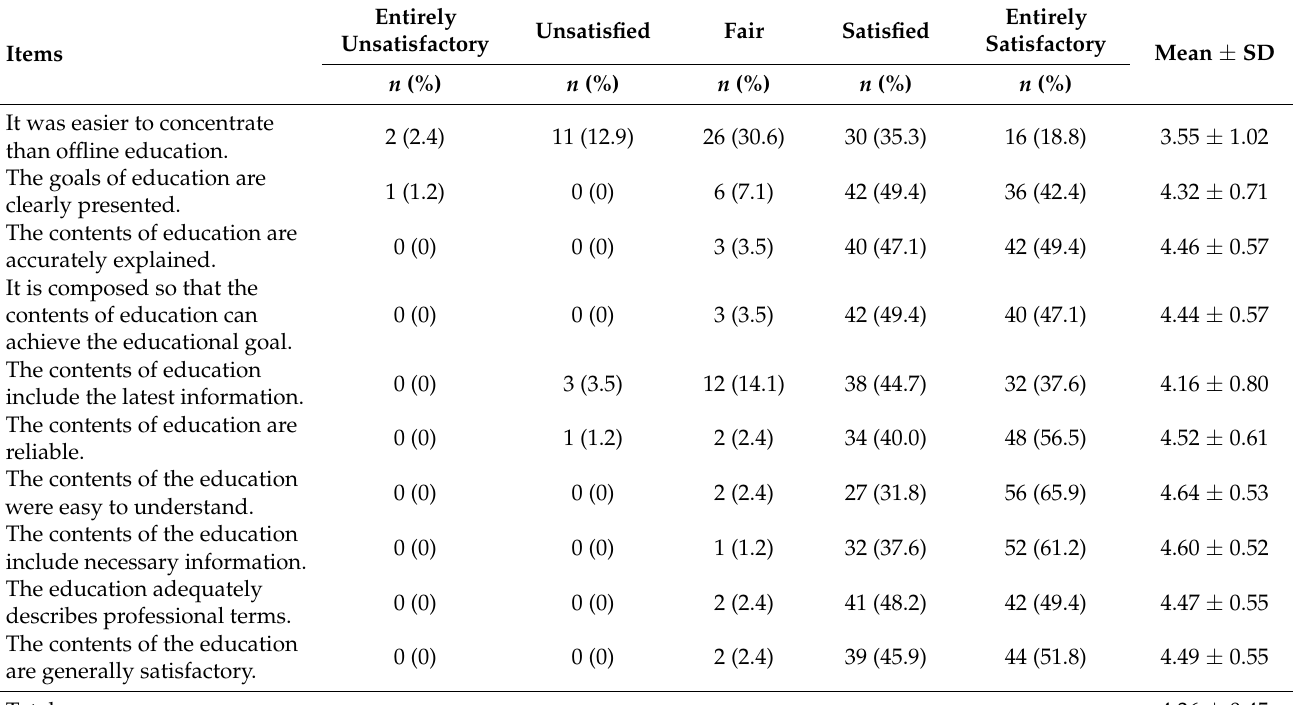
Table 4. Satisfaction toward web-based educational program among experimental group ( n =